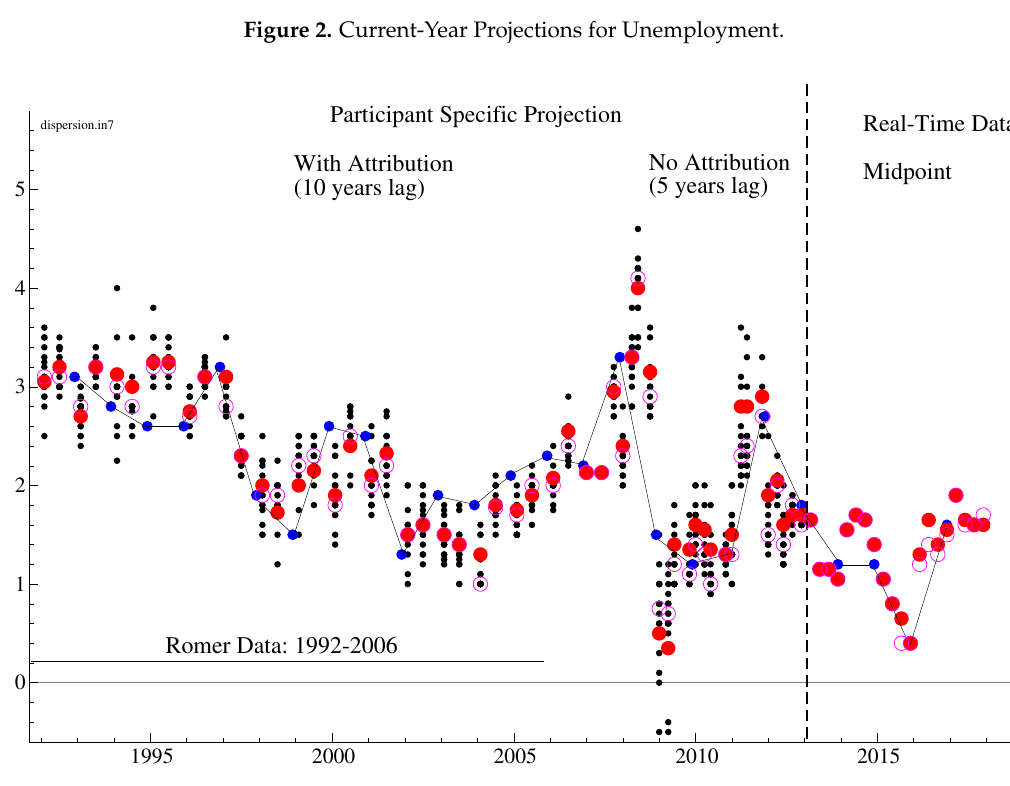
Figure 3. Current-year Projections for